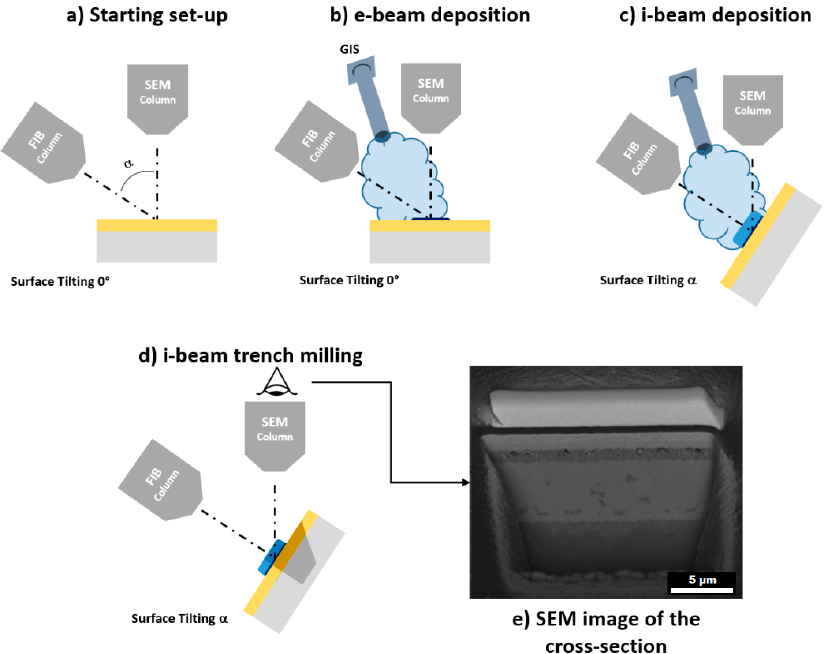
Figure 2. An example of FIB cross-sectioning workflow: ( a ) the sample is inserted in the chamber with 0° tilt; ( b ) a thin layer of metal is deposited on the surface using the electron beam; ( c ) the stage is tilted and a thicker metallic layer is deposited using the ionic beam; ( d ) the focused ionic beam is rastered on the surface creating the cross section by sputtering effect; ( e ) final SEM image of the cross-